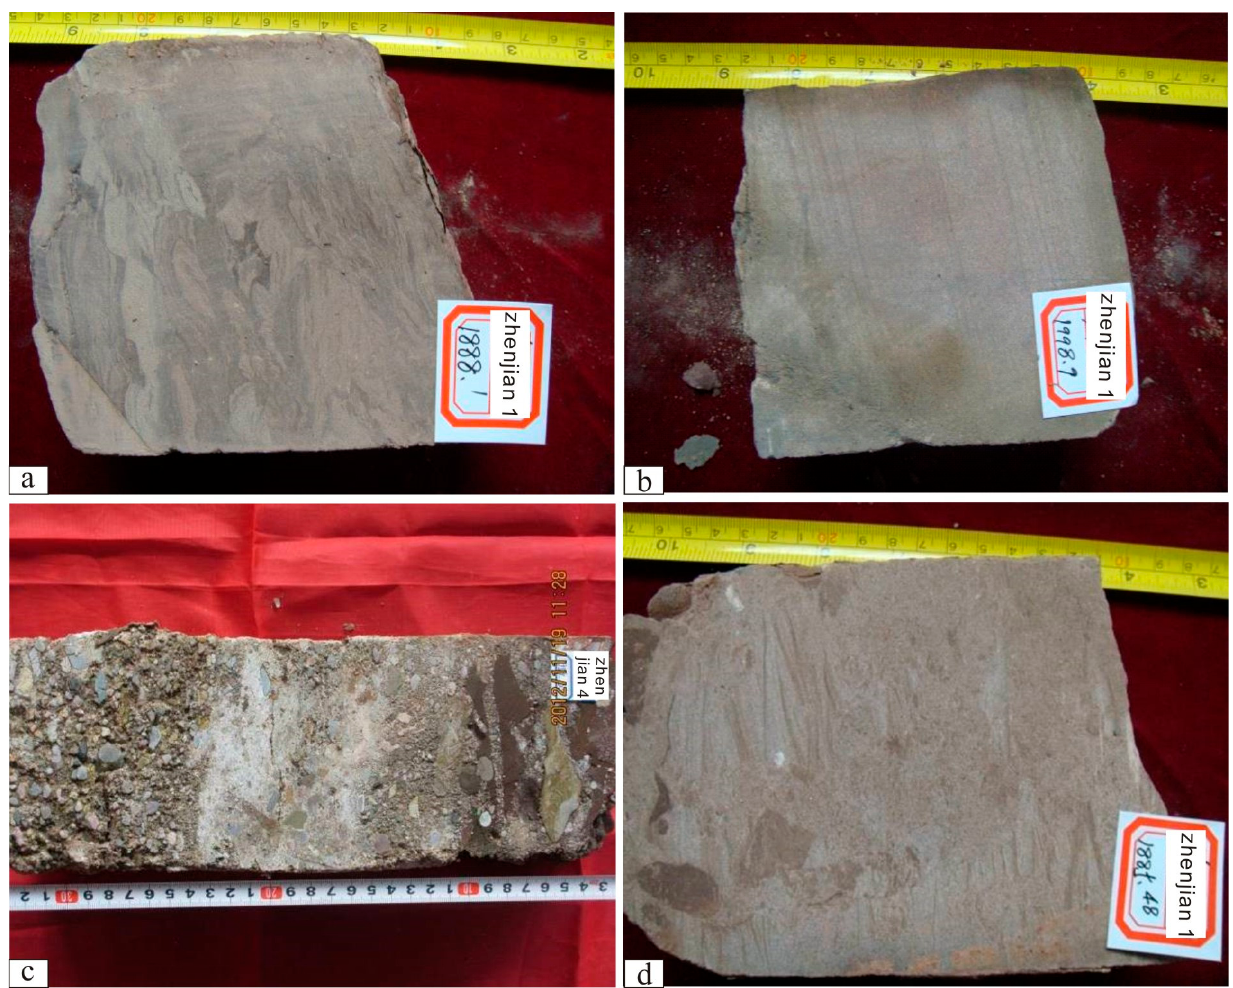
Figure 2. Typical sedimentary structure of E 2 s 14–7 in the Zhenwu area, Gaoyou Sag. ( a ) Zhenjian 1 well, cross ‐ bedding, 1888 m; ( b ) Zhenjian 1 well, parallel bedding, 1998.9 m; ( c ) Zhenjian 4 well, scour ‐ and ‐ fill structure, 1951.65 m; ( d ) Zhenjian 1 well, bioturbation, 1885.48 m.